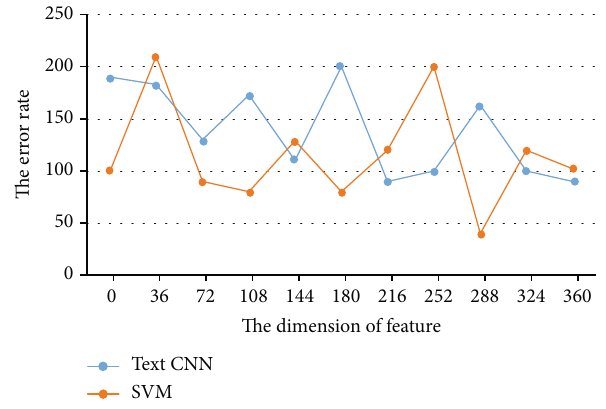
Figure 8: Relationship between feature dimension and classi fi cation error